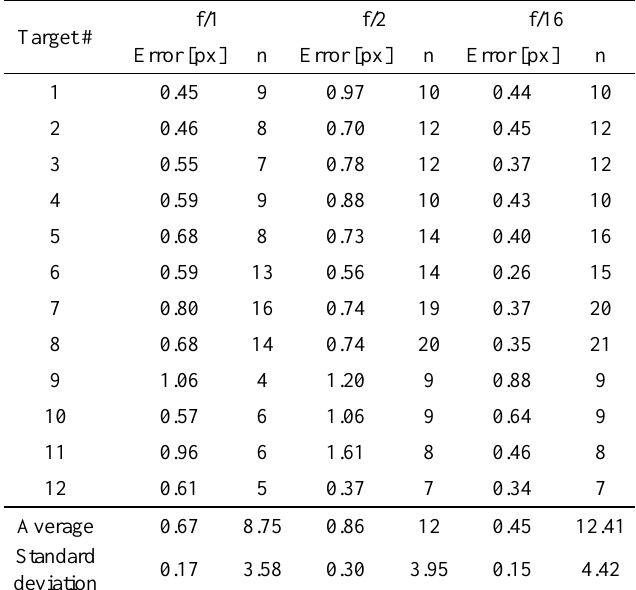
Table 5. Forensic Scene: Target error in Lytro image sets in detail per target (See Table